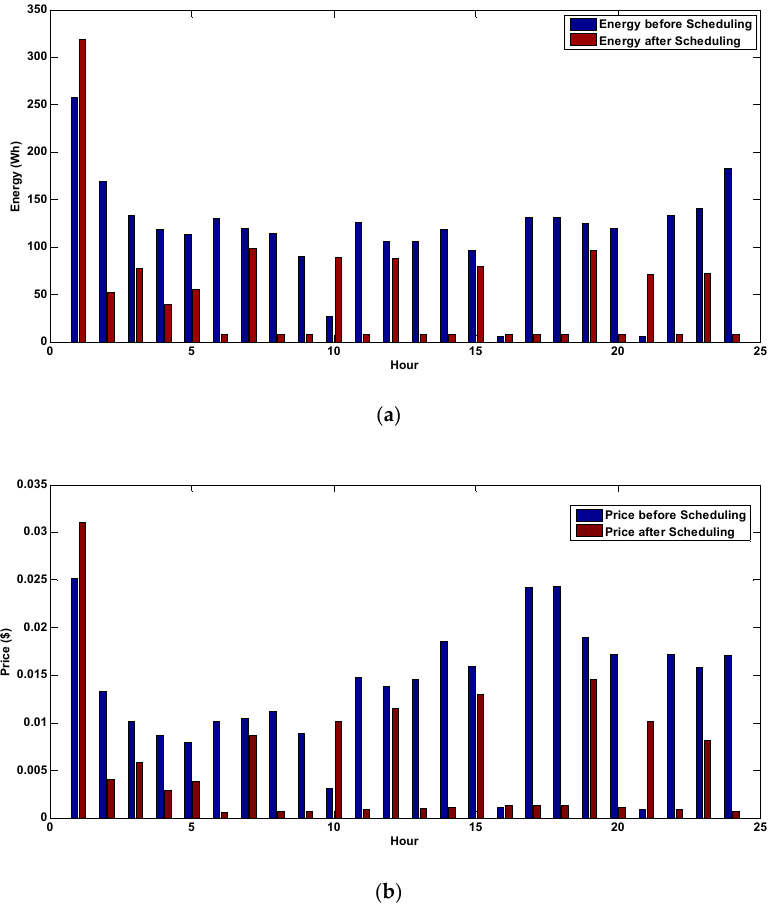
Figure 24. ( a ) Energy consumptions and ( b ) bills incurred by the water heater without and with the use of the HEM system.